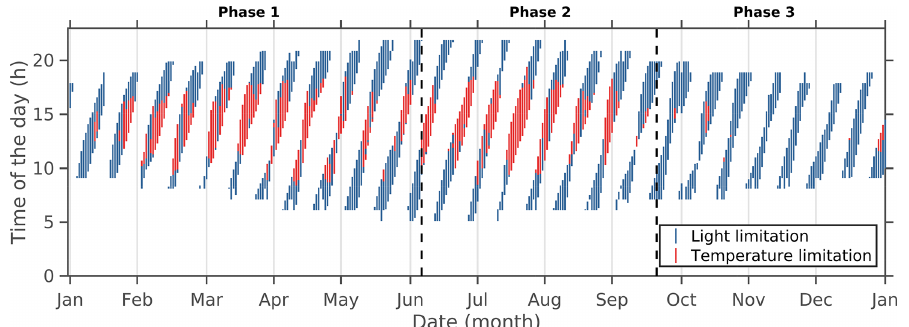
Figure 9. Simulated time occurrence of the light or temperature limitation of the MPB growth rate over daytime emersion periods in 2008.